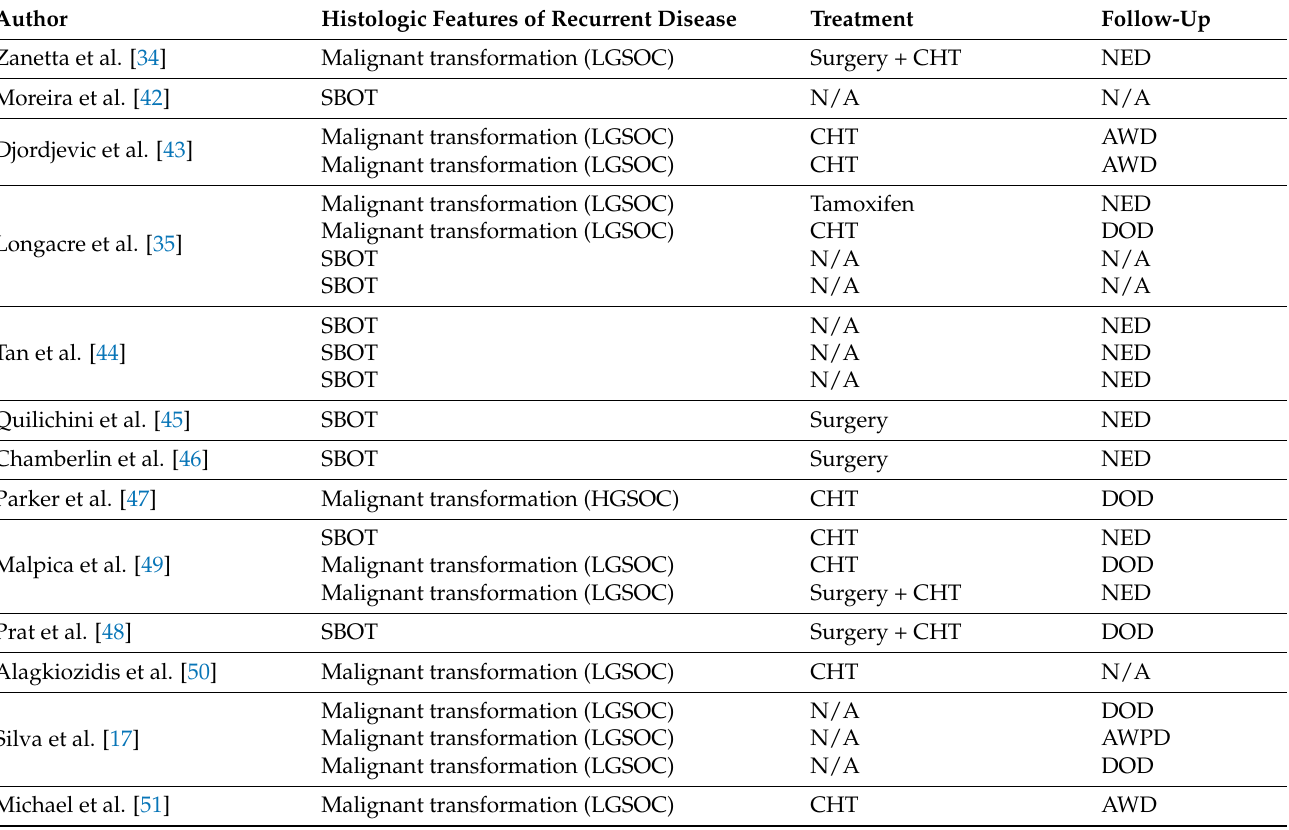
Pathology, management, and outcome of primary SBOT with nodal involvement at